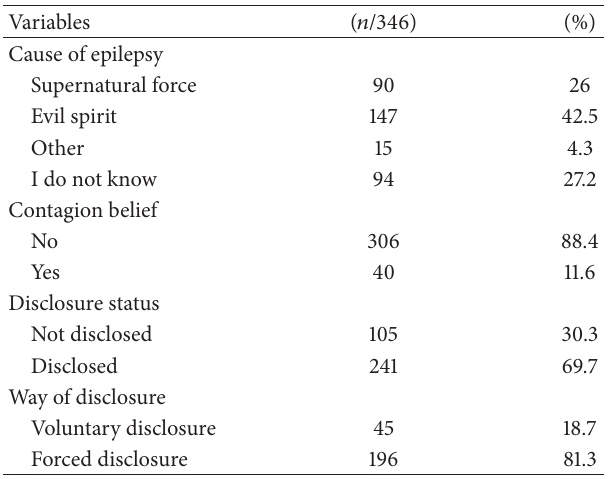
Table 3: Distribution of study subjects by disclosure status, patient’s contagion belief, and causal belief of epilepsy.